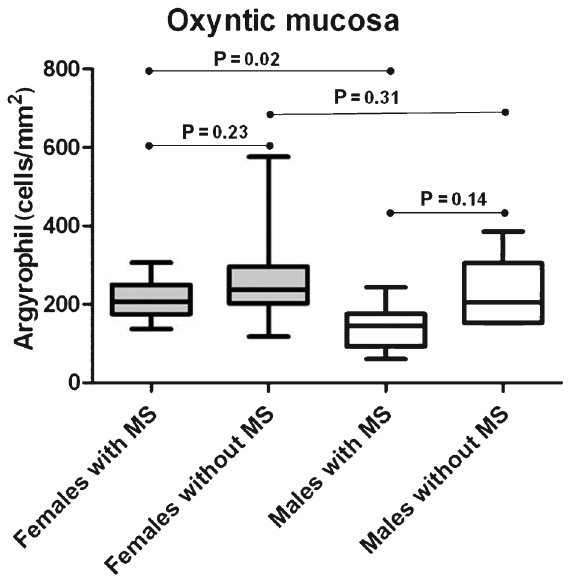
Figure 2. Argyrophil cell density in the oxyntic mucosa of female and male morbidly obese patients with and without metabolic syndrome (MS).